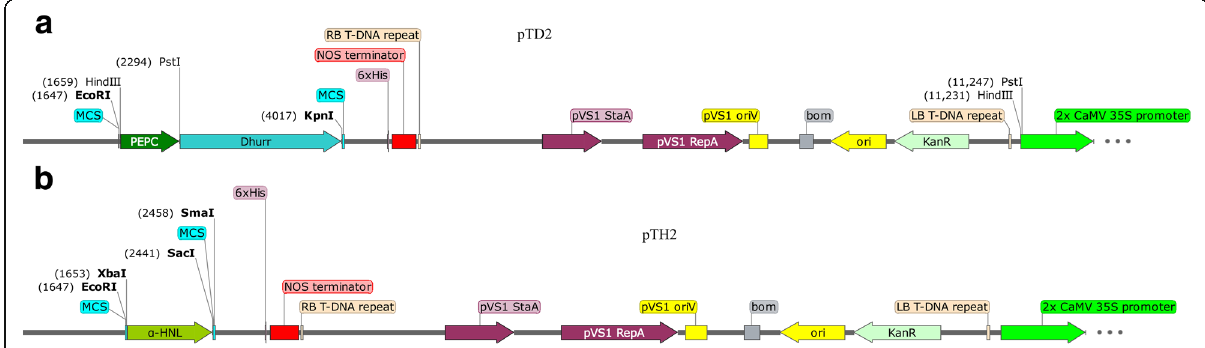
Fig. 1 Schematic representation of plasmid vectors maps employed in this study, a pTD2 (pYL156 (pTRV-RNA2) + SbDhr 2) here dhurrinase2 gene is under control of PEPC promoter, b pTH2 (pYL156 (pTRV-RNA2) + MeHNL ), α -Hydroxynitrile lyase gene is under control of 2X CaMV